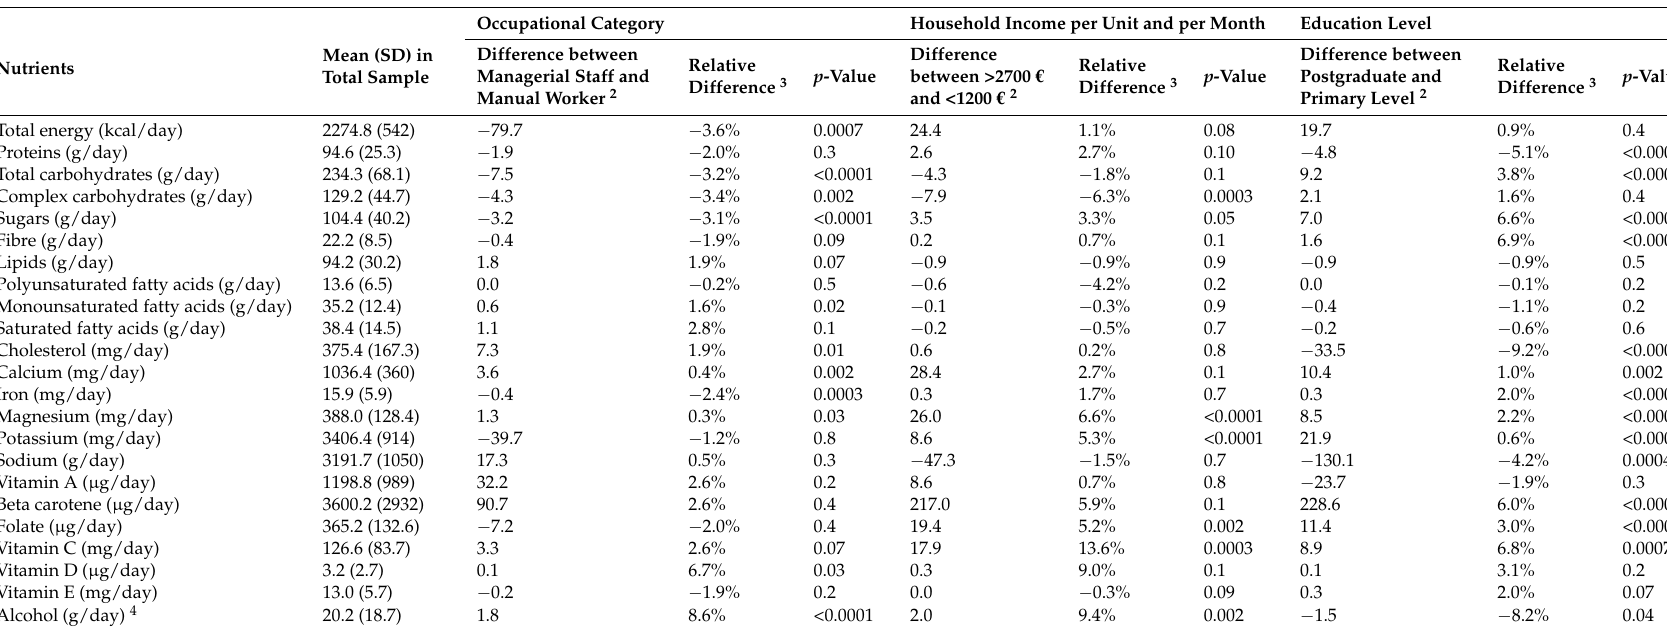
Table 3. Differences in nutrient intake between the highest and the lowest SEP categories of occupation, household income and education in men ( N = 19,746) 1 .